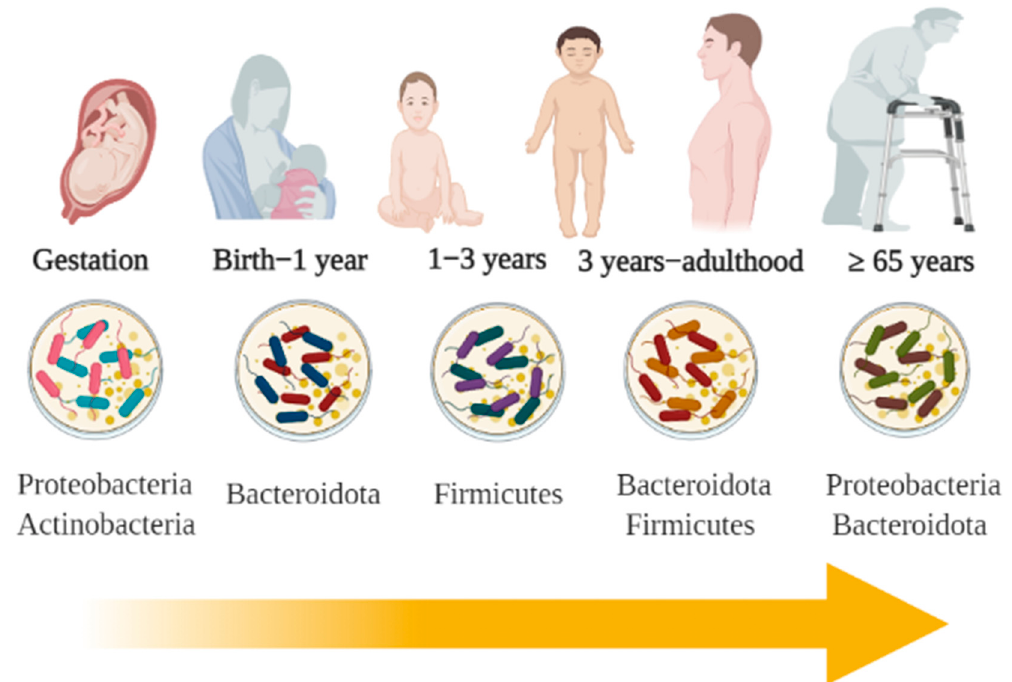
Figure 1. Dominant gut microbiota phyla in different life stages.